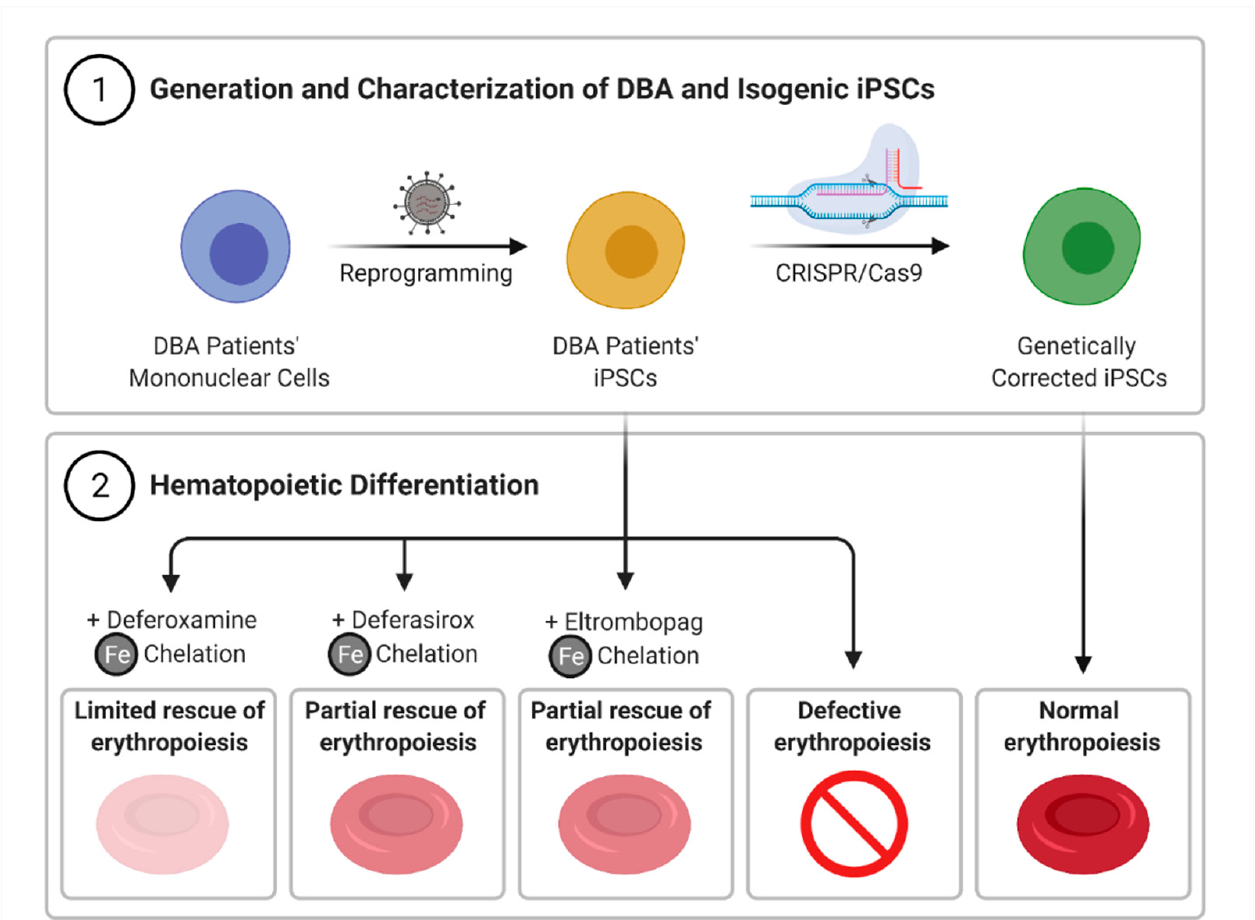
Figure 5. Summary. iPSC lines were generated from blood cells of DBA patients, and isogenic iPSC clones were produced by CRISPR-mediated correction of RPS19 mutations. Hematopoietic differentiation of DBA iPSCs phenocopied the erythroid maturation defect found in DBA. Defective erythropoiesis was partially rescued by eltrombopag and deferasirox, but did not improve substantially with deferoxamine, consistent with a mechanism based on intracellular iron chelation. Supplementary Materials: The following are available online at https://www.mdpi.com/article/ Figure S2: Absence of Sendai vector-derived antigens in DBA iPSCs, Figure S3: DBA iPSCs display characteristics of pluripotency in flow assays, Figure S4: DBA iPSCs display characteristics of pluripotency in teratoma assays, Figure S5: DBA iPSCs display ribosome biogenesis defects, Figure S6: Generation of isogenic iPSCs using CRISPR/Cas9 technology, Figure S7: Isogenic iPSCs display a normal karyotype and characteristics of pluripotency, Figure S8: Isogenic and DBA iPSCs give